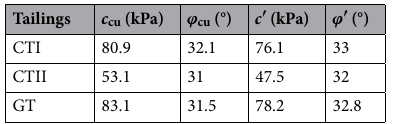
Table 5. Shear strength parameters of tailings.